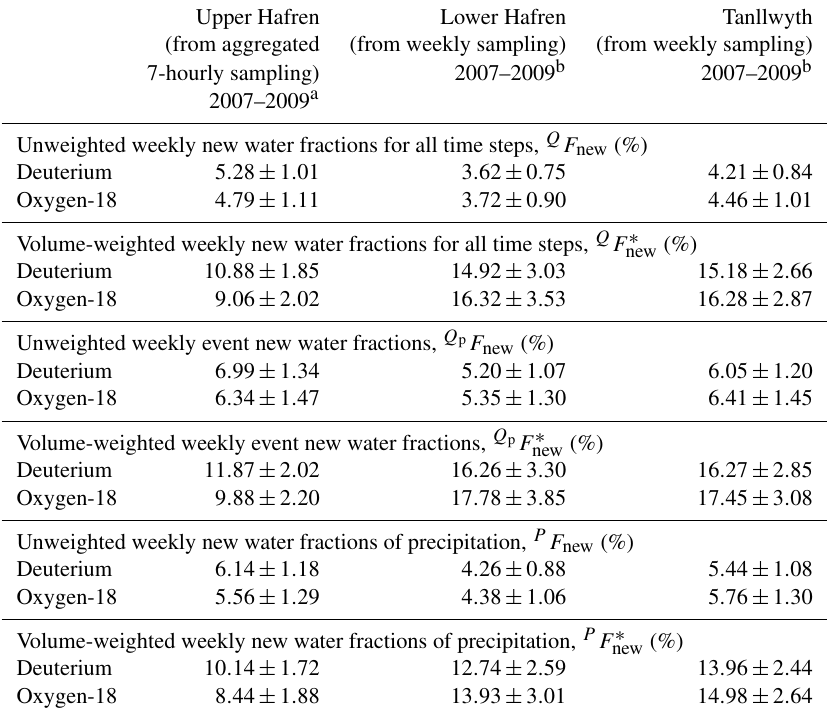
Table 2. Comparison of weekly new water fractions ( ± standard errors) at the Upper Hafren, Lower Hafren, and Tanllwyth. Upper Hafren Lower Hafren Tanllwyth (from aggregated (from weekly sampling) (from weekly sampling) 7-hourly